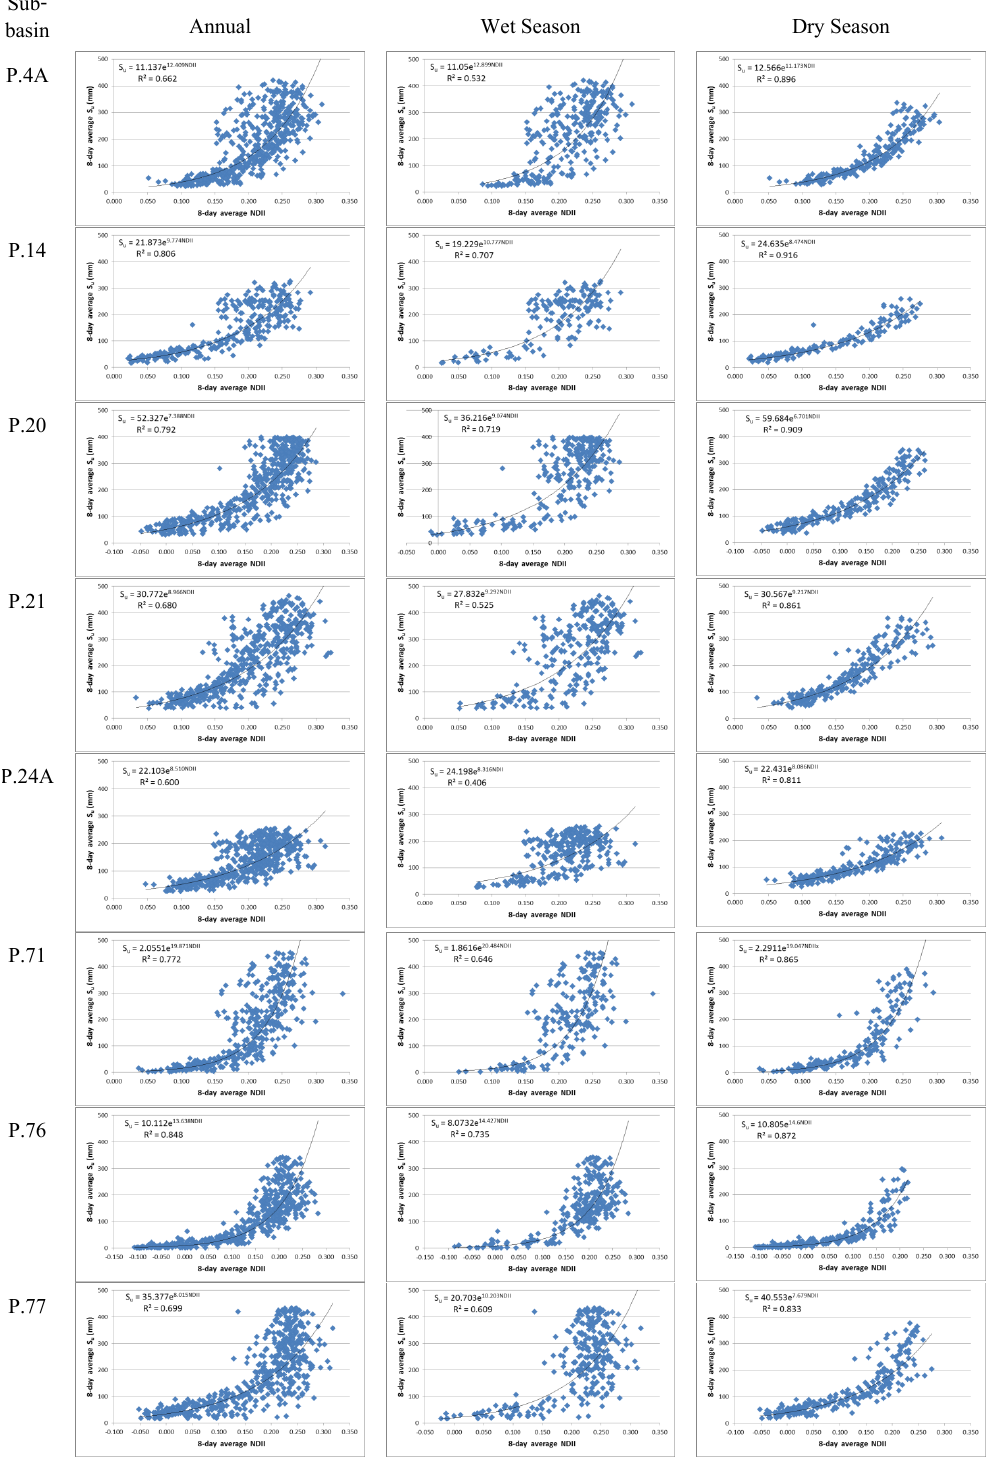
Figure 6. Scatter plots between the average NDII and the average root zone moisture storage ( S u ) for eight sub-basins controlled by runoff stations. Regression lines are added merely to illustrate the degree of